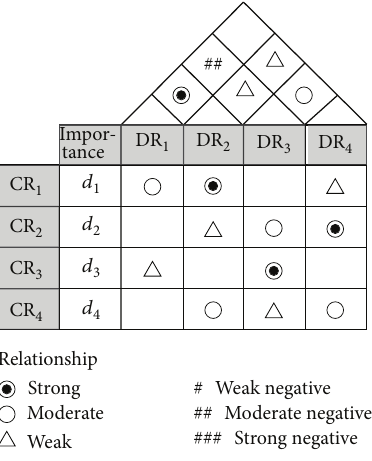
Figure 1: Matrix structure of